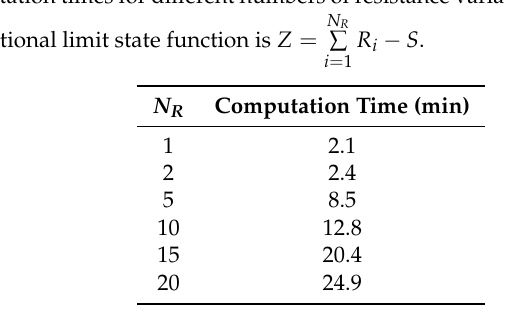
Table 5. BN computation times for different numbers of resistance variables ( N R ), for a 1000 m segment, where the cross sectional limit state function is Z =